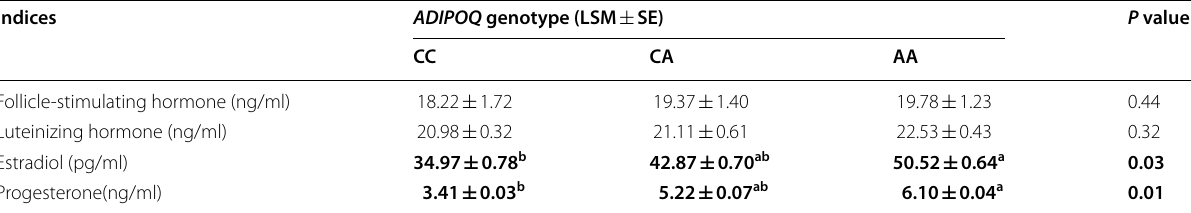
LSM SE least square means ± indicates the P value with statistical significance